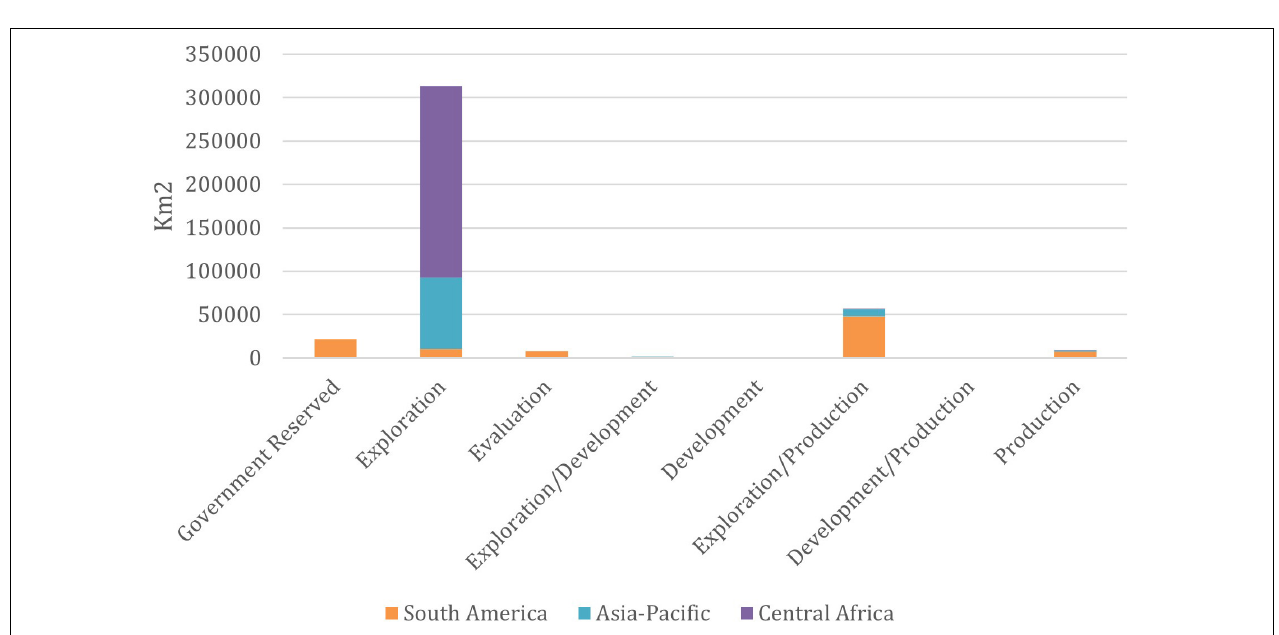
FIGURE 4 | The type of mining commodity where mining claims overlap IFLs. Central Africa is missing as the data was unclear and could not be reasonably summarized.